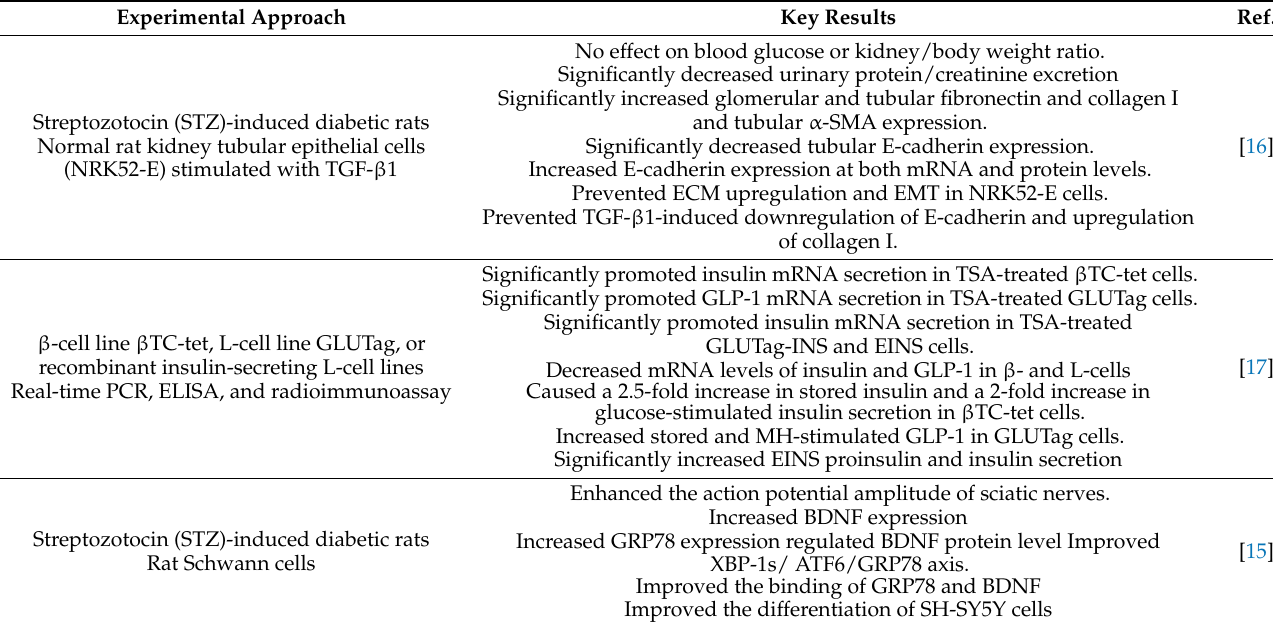
Table 2. Antidiabetic effects of Trichostatin